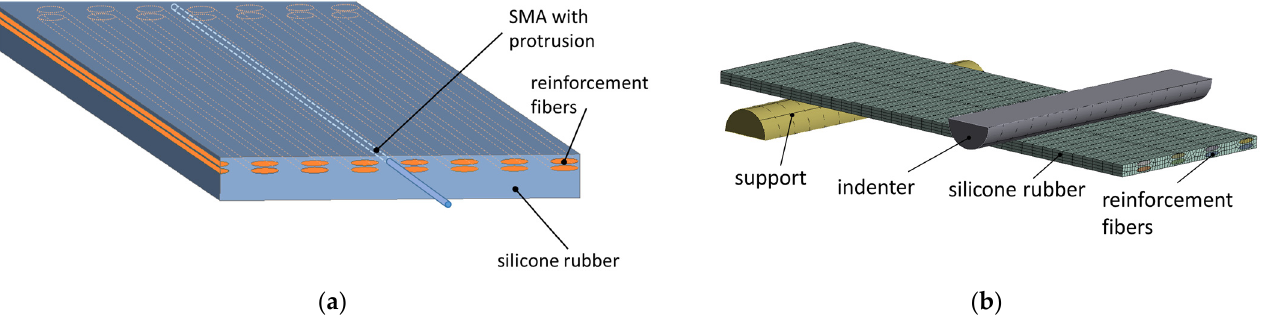
Figure 9. ( a ) The IFRC simulation model concept and ( b ) the four-point-bending model of the FRC without SMA and with symmetry. Table 2. Geometry modeling parameters.